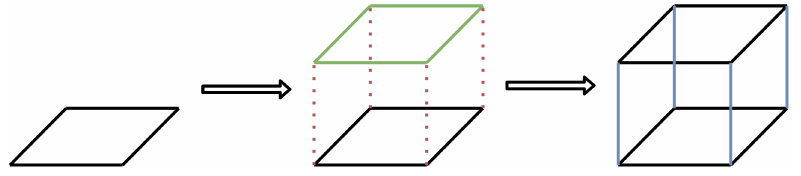
Figure 3. Simple building polygon reconstruction in